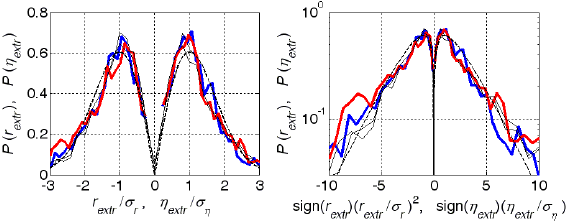
An example of such forecast is shown in Fig. 11 for for 3.0 = s Br , where the forecasted probability